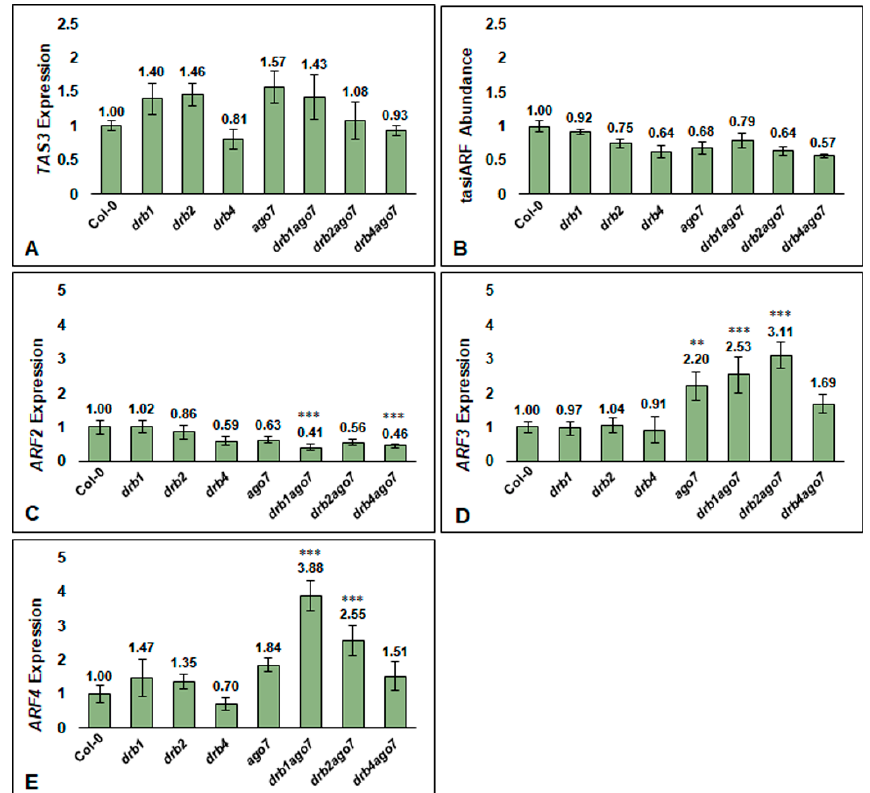
Figure 4. RT-qPCR based assessment of TAS3 precursor expression, tasiARF sRNA abundance, and the expression of the ARF2 , ARF3 and ARF4 target transcripts. ( A – E ) RT-qPCR based quantification of ( A ) TAS3 precursor transcript expression, ( B ) tasiARF sRNA abundance, and the expression of the three tasiARF target genes, ARF2 , ( C ) ARF3 , ( D ) and ARF4 ( E ) in the terminal floral buds of 42-day -old Col-0, drb1 , drb2 , drb4 , ago7 , drb1ago7 , drb2ago7 , and drb4ago7 plants. Error bars represent the standard error of the mean of the four biological replicates quantified. The fold change in expression relative to wild-type flowers is presented above each column. The presence of an asterisk above a column represents a statistically significant di ff erence between the mutant plant line and Col-0 plants ( p -value: ** < 0.005; *** <